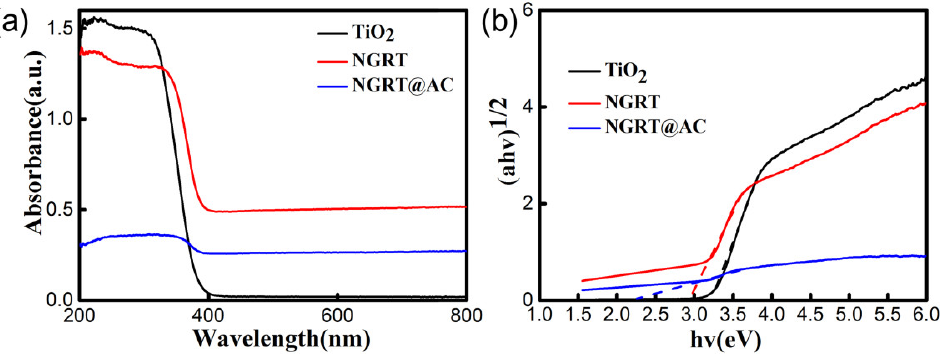
Figure 3. ( a ) UV–vis diffuse reflection spectra of the nanocomposite and ( b ) the band gap of the nanocomposite estimated by plotting (∂hv) 1/2 versus (hv).